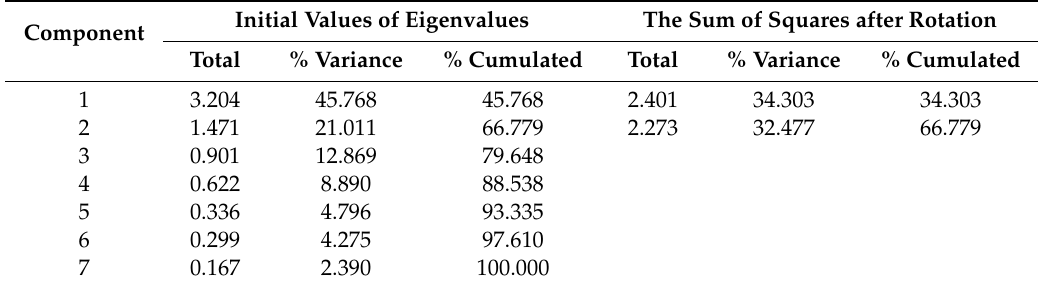
Table 18. Identification of two components of Customer Relationships Importance